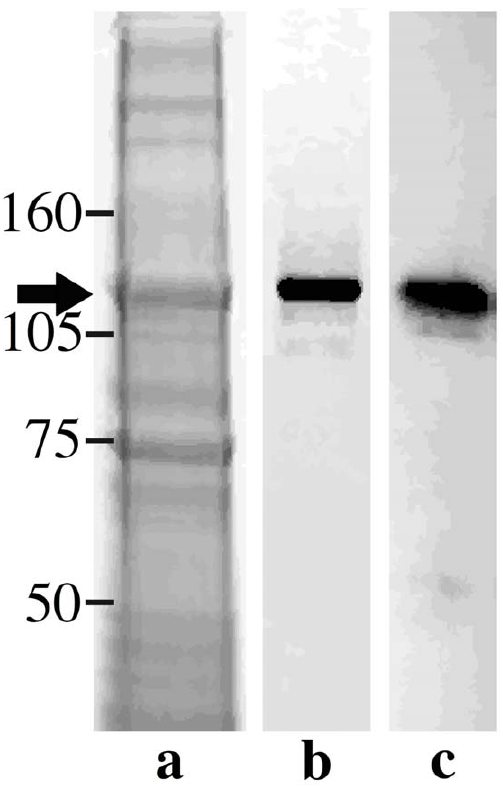
Figure 8. Immunoblotting of the 130 kDa salivary gland protein probed with anti-human laminin-5 b 3 chain antibodies. Total salivary gland proteins were extracted and separated by 10% SDS- PAGE ( a ). The 130 kDa band was cut and purified from the gel and the purity of the product was evaluated by 10% SDS-PAGE stained with silver nitrate ( b ). The purified 130 kDa protein was probed with anti- human laminin-5 b 3 chain antibodies ( c ). The arrow shows the position of the 130 kDa protein on SDS-PAGE and the stained band by immunoblotting.